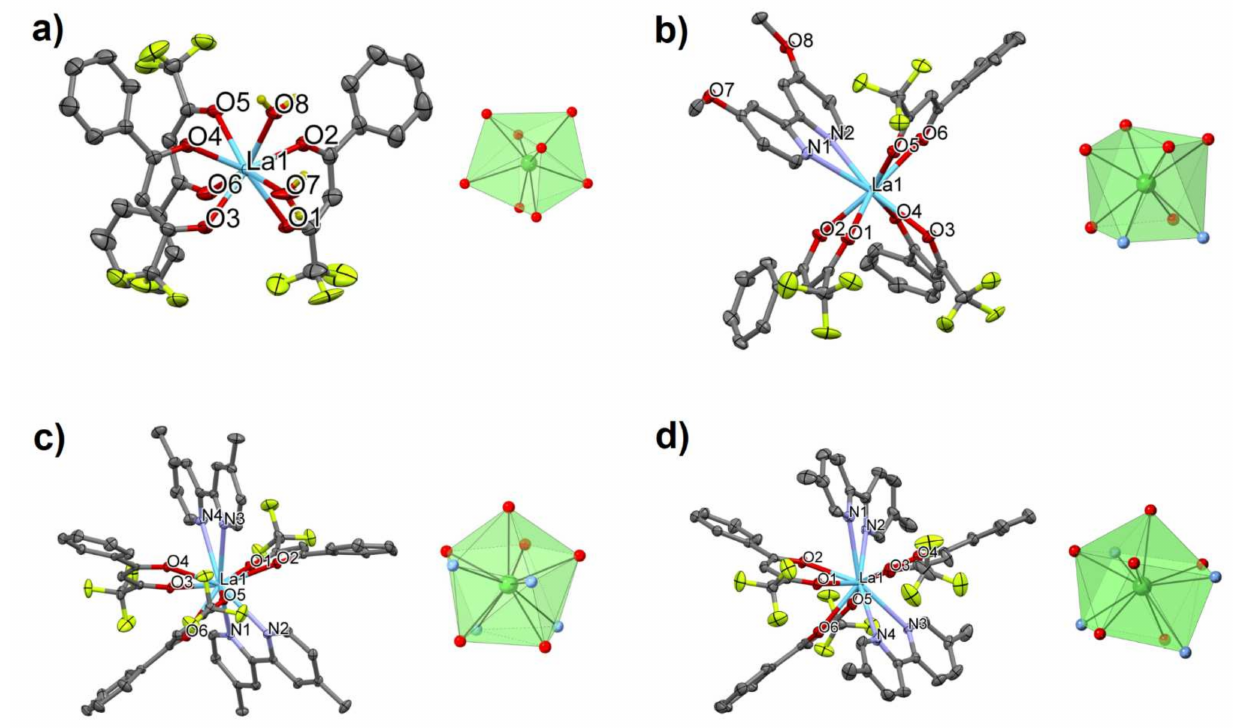
Figure 1. ( a – d ) Perspective view and coordination figure of 1–4 , respectively.